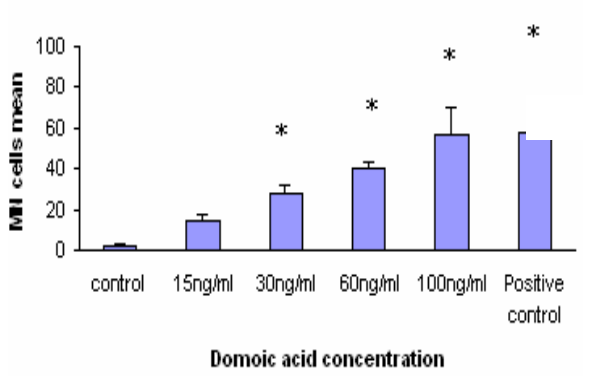
Figure 3: Micronuclei (MN) frequency in Caco-2 cells exposed to DA. Data are expressed as mean ± SD. *indicates significant differences as compared to negative control ( P <0.05).